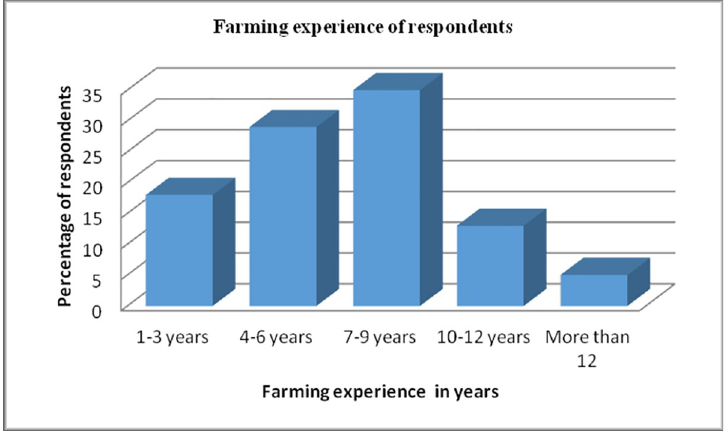
Fig 4. Farming experience of respondents. Farming experience- this graph represents the farming experience of the respondents in years. On X-axis faring experience in years was mentioned while on Y-axis percentage of the respondents was mentioned. This data revealed that most of the respondents have 7–9 years of farming